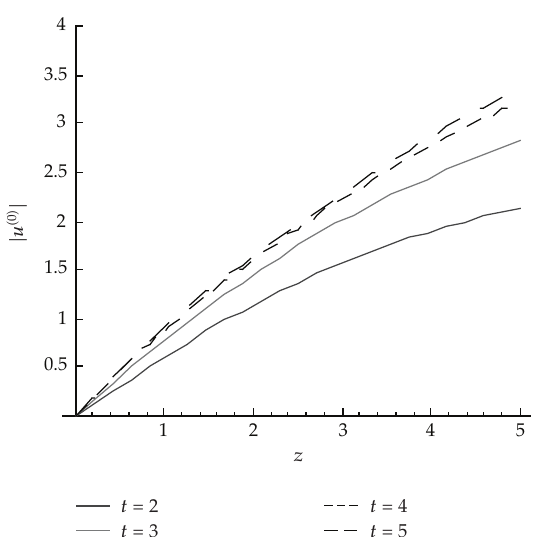
Figure 3: The zero-order approximation | u (cid:3) 0 (cid:4) | at α (cid:8) 1, T (cid:8) 10, γ (cid:8) 02 for di ff erent values of t , considering only one term in the series (cid:3) M (cid:8) 1 (cid:4) .